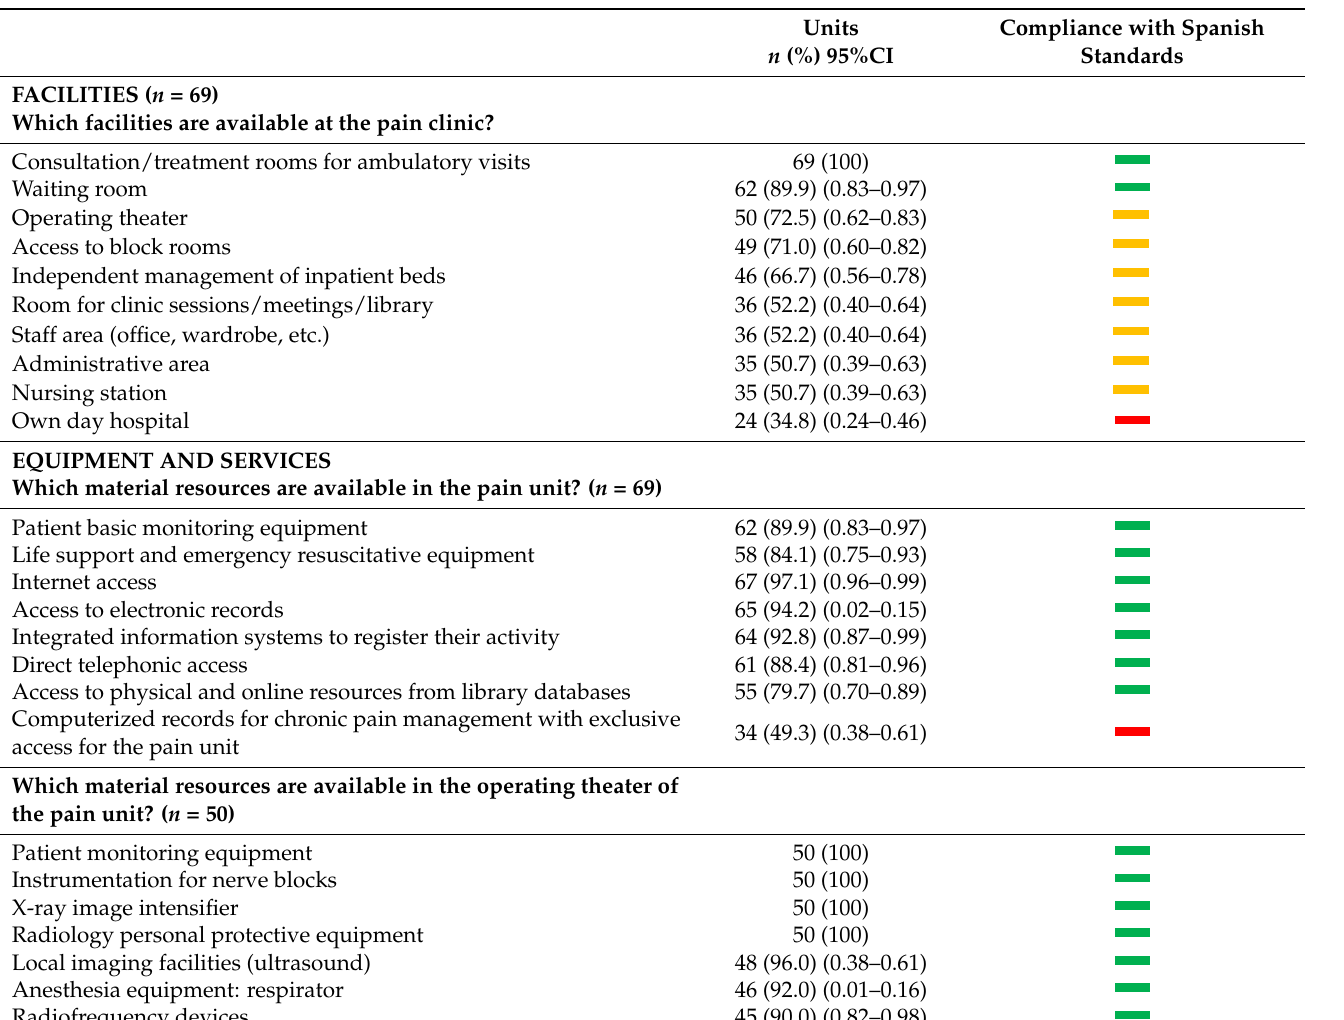
Table 1. Facilities and resources available in a sample of Spanish pain units in 2018.